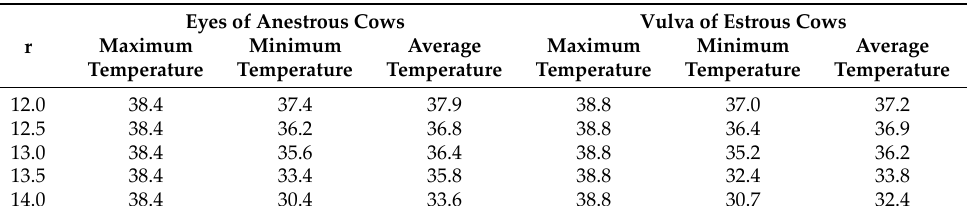
Table 4. Data table of maximum, minimum and average temperatures of vulva of anestrous and estrous cows with different profiles.